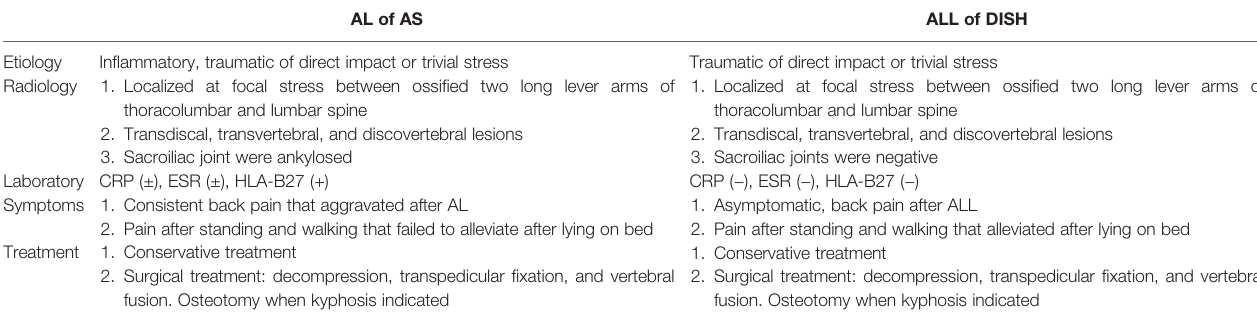
TABLE 2 | Characteristics of the similarity and differences between AL of AS and ALL of